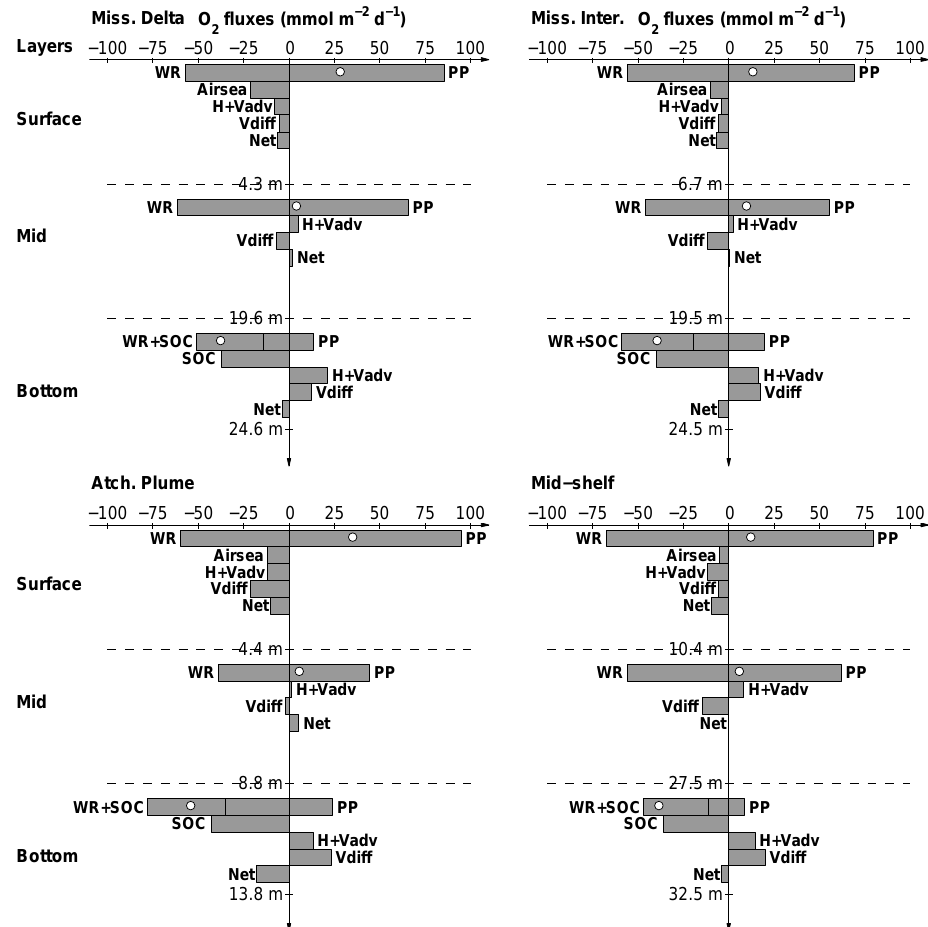
Figure 9. Simulated 4-year (2004–2007) mean oxygen balance in summer for the four sub-regions. Oxygen source and sink terms are given for the surface layer above the pycnocline, for the mid-layer, and for the 5m thick bottom layer. The average depth of the pycnocline, depth at 5m above bottom, and the average water column depth are indicated for each sub-region. The open circles indicate the balance of primary production (PP) and respiration + nitrification (WR) in each layer. For the bottom layer, the bars for respiration + nitrification (WR) and sediment oxygen consumption (SOC) are shown stacked and SOC is repeated separately. The net rate of oxygen change in each layer (i.e., the sum of all oxygen source and sink terms) is given and denoted as